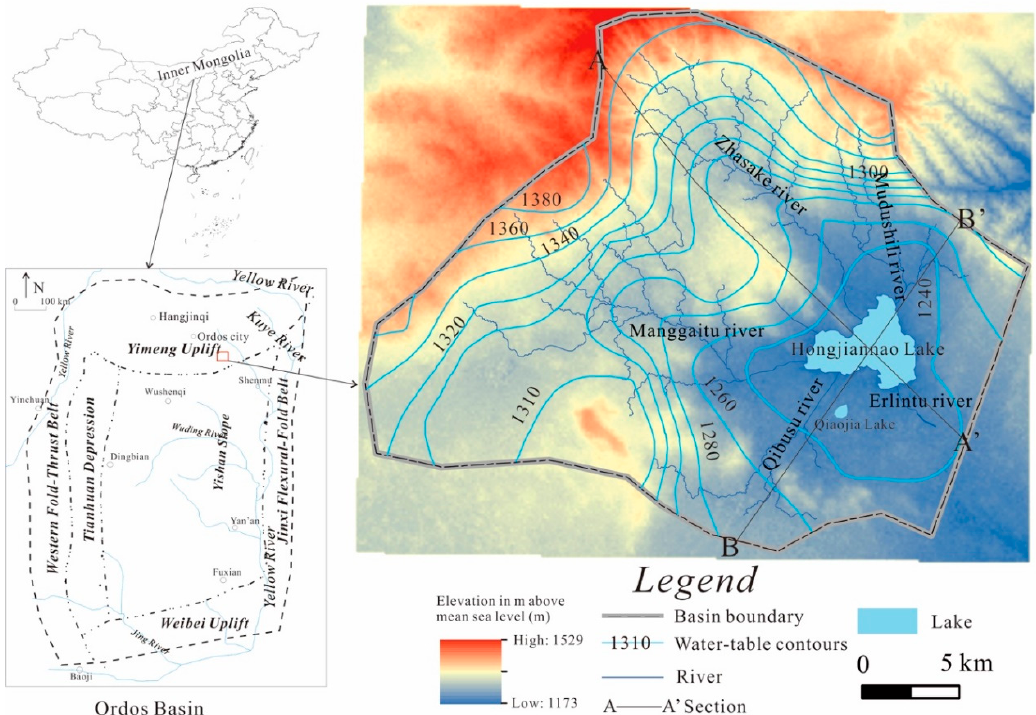
Figure 1. Location and hydrogeological condition of the study area.